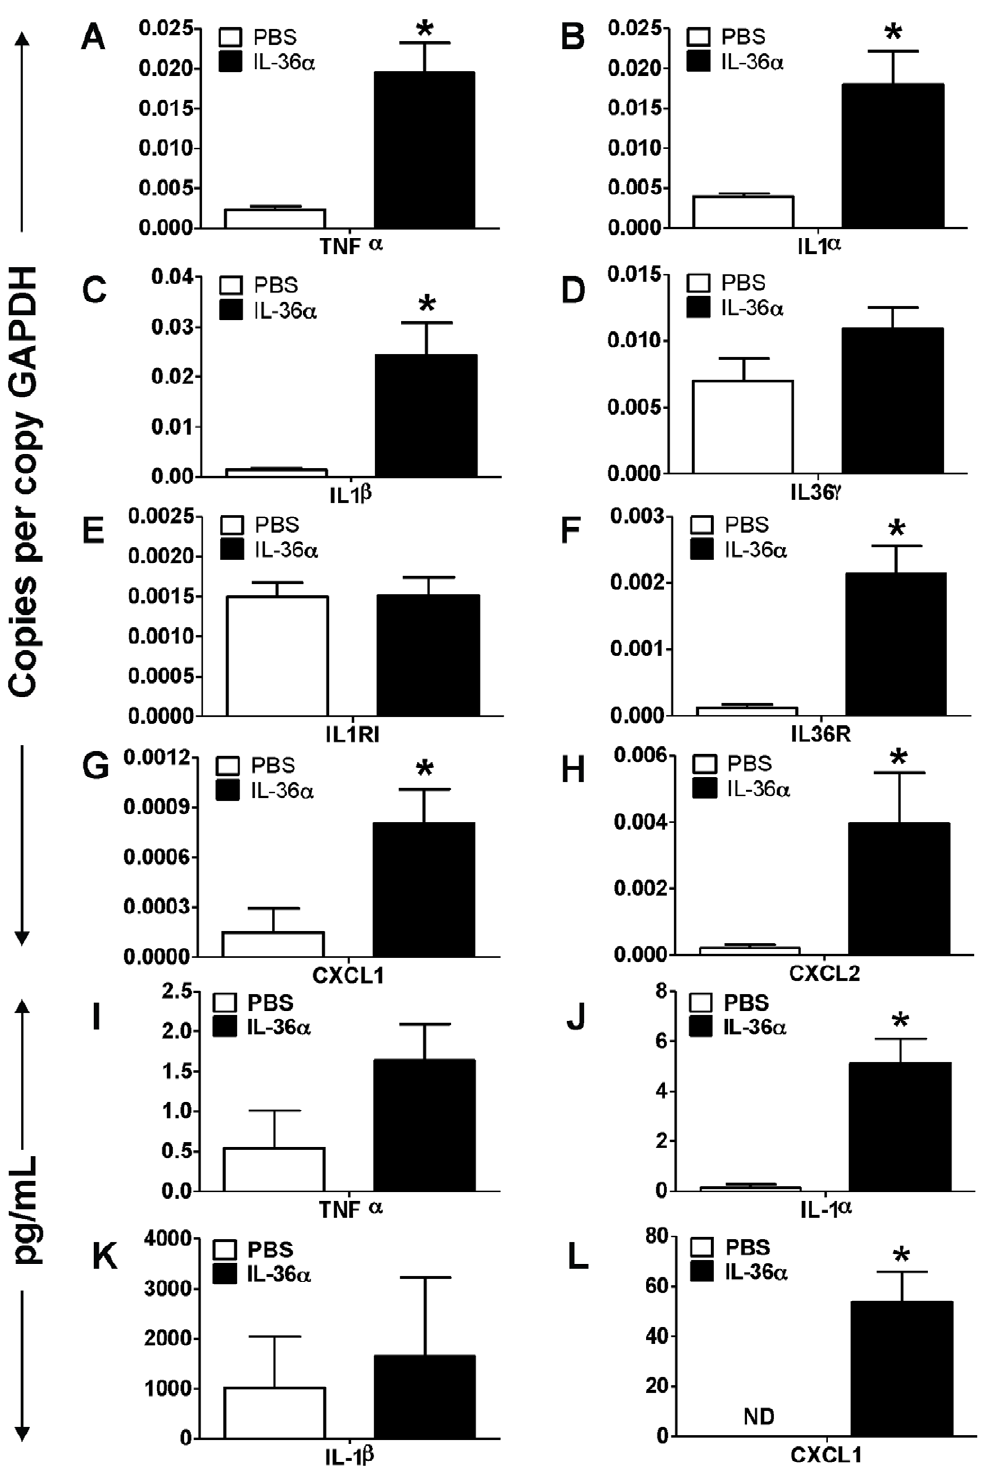
Figure 2. Intratracheal instillation of IL-36 a increased the mRNA expression of proinflammatory mediators in the lungs of wild-type C57BL/6 mice. A–H) Transcript expression of early response cytokines (TNF a , IL-1 a , IL-1 b , IL-36 c ), the classical IL-1 receptor IL-1R1, the novel IL-1 cytokine cluster receptor IL-36R and the neutrophil specific chemokines CXCL1 and CXCL2 in the lungs of mice 24 h following a single i.t instillation of PBS or 10 m g IL-36 a . Transcript expression was evaluated by SYBR-Green based quantitative real-time PCR. I–K) Protein expression of TNF a , IL-1 a , IL-1 b and CXCL1 in the BAL fluid recovered from mice 24 h following a single i.t instillation of PBS or 10 m g IL-36 a . Protein expression was quantified by multiplexed cytometric bead arrays. *Indicates significant differences ( P , 0.05 ) compared to PBS treated mice. Data represent mean 6 SEM from 4– 5 mice/group.